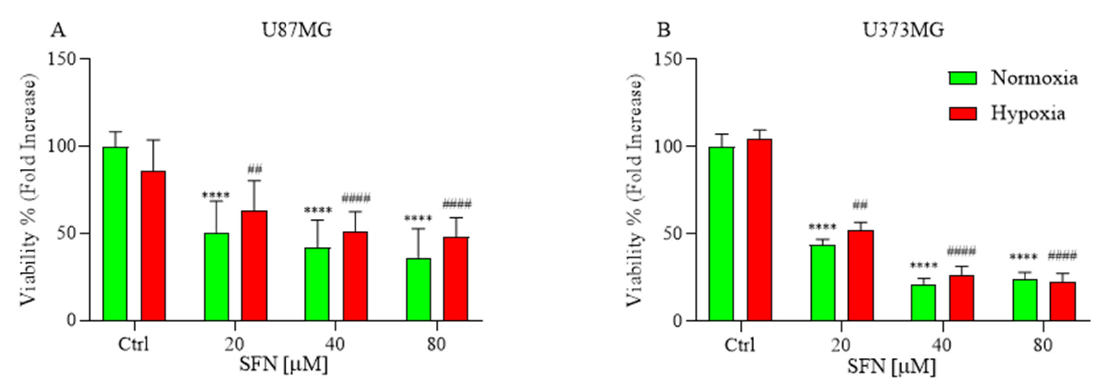
Figure 1. Effects of SFN on cell viability after 48 h of treatment [20–80 µM] in normoxic (green) or hypoxic (red) conditions. All SFN concentrations induced a significant decrease in cells viability in U87MG ( A ) and U373MG ( B ) cell lines. Data are expressed as fold increases in the percentage of cell viability versus corresponding controls and reported as mean ± SD of three independent experiments (**** p < 0.0001 vs. normoxic Ctrl group; ## p < 0.01 and #### p < 0.0001 vs. hypoxic Ctrl group. Two-way ANOVA, post hoc test Bonferroni).